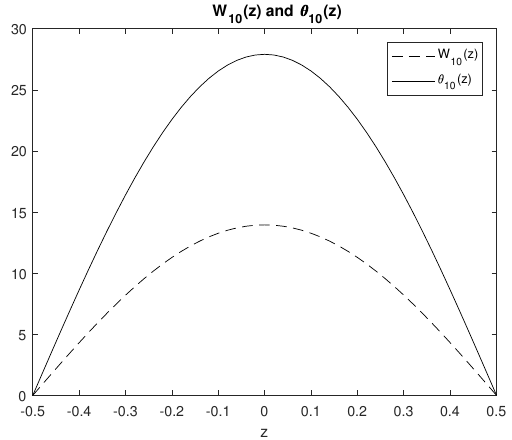
Figure 1. Zeroth order solutions W 10 ( z ) .